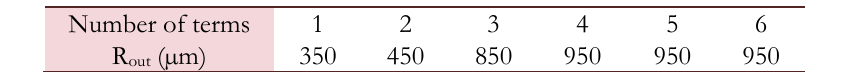
Table 2: Combination of number of terms and outer radius, R out , that give a minimum error in Fig.